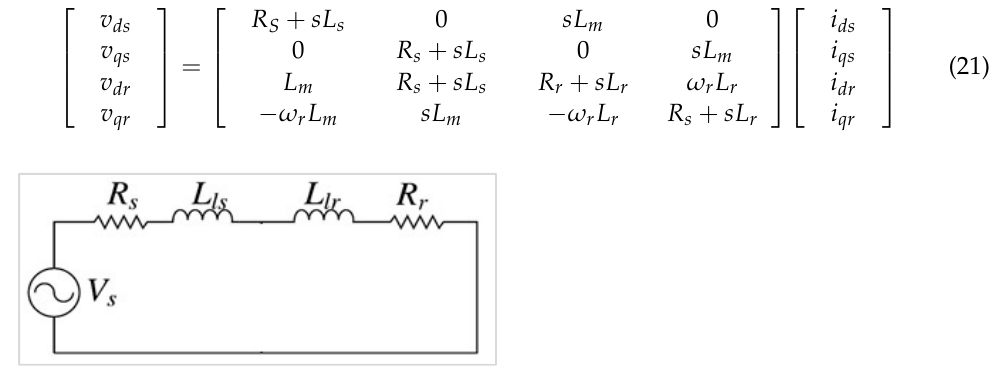
Figure 11. Equivalent circuit of the locked rotor. Figure 12 illustrates a static model of an induction motor.